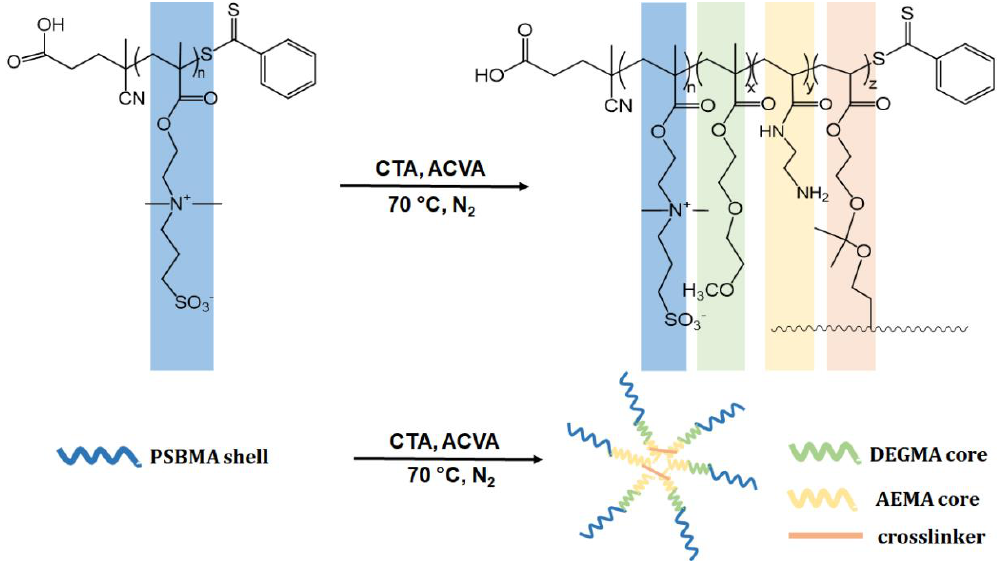
Scheme 1. Synthesis of CCMs by RAFT